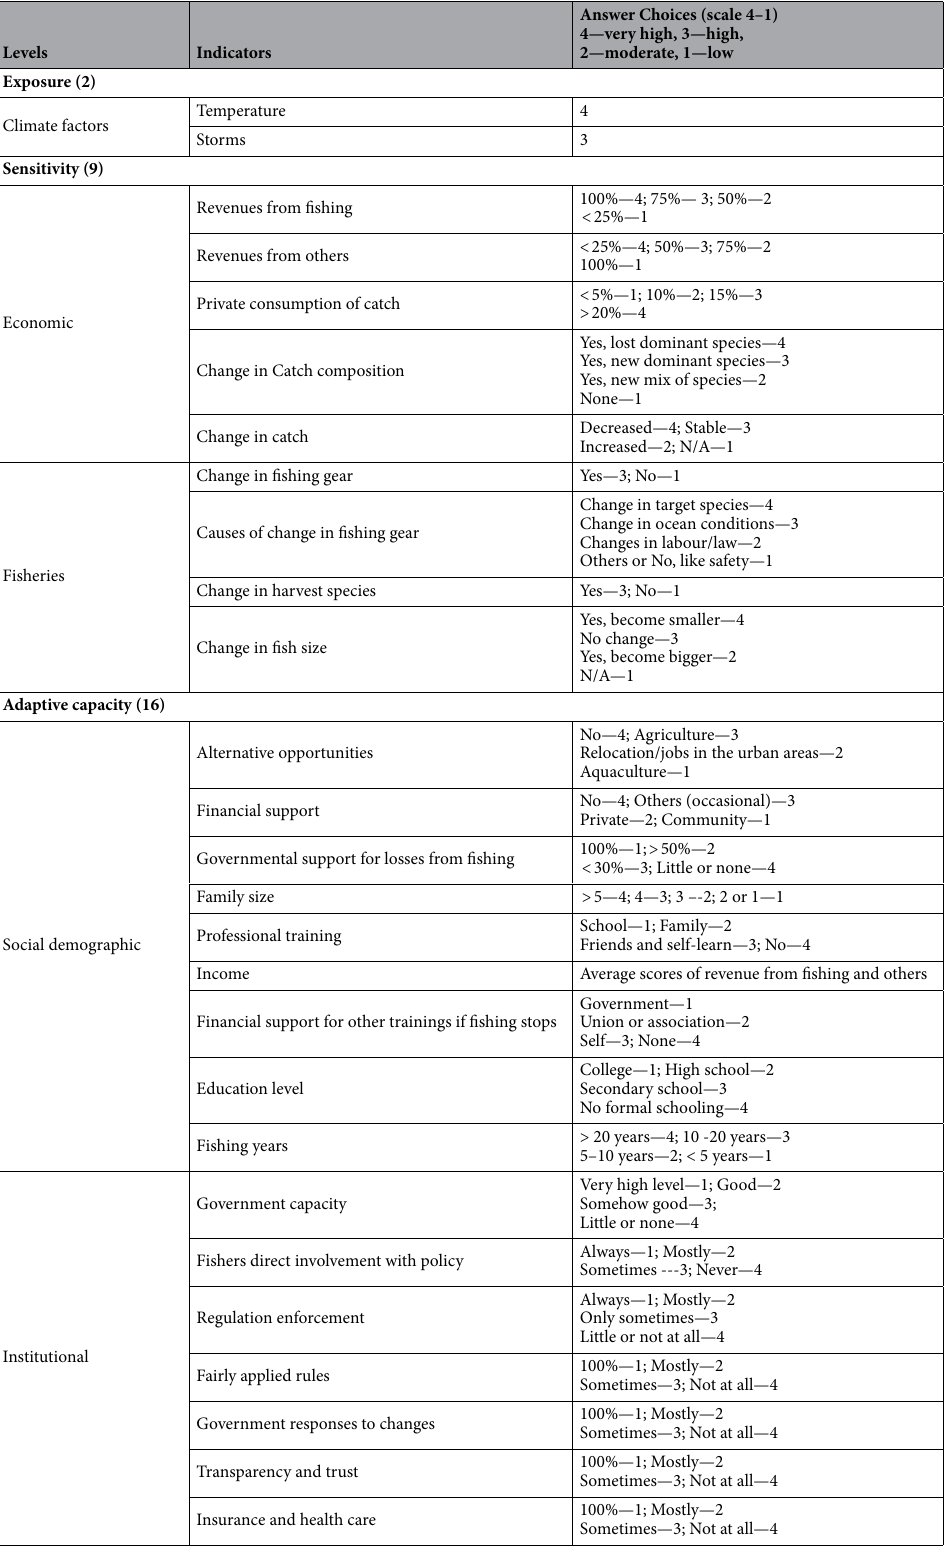
Table 1. Vulnerability levels and selected